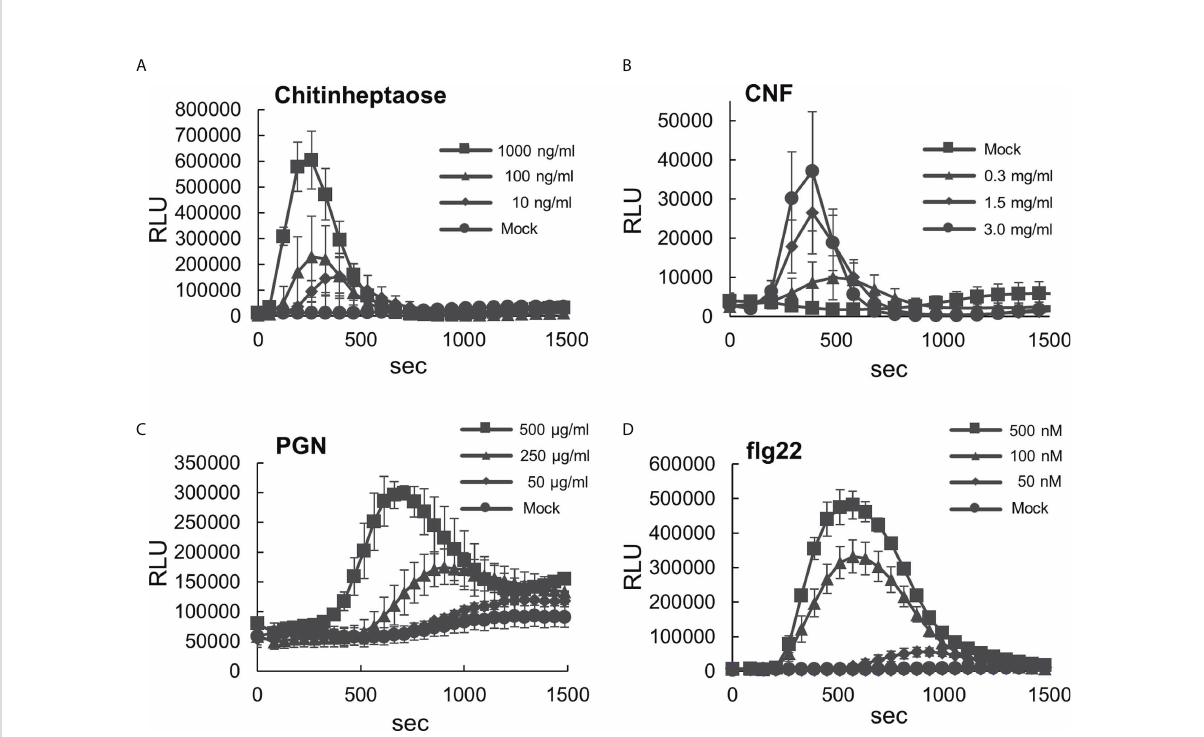
FIGURE 1 Analysis of reactive oxygen species (ROS) production in the leaf disks of Brachypodium distachyon treated with various MAMPs. (A – D) Leaf disks of B distachyon treated with chitinheptaose (A) , fl g22 peptide (B) , peptidoglycan (C) , and chitin nano fi ber (D) . Fluorescence was measured using a microplate reader and expressed as a relative light unit (RLU). Data represent mean ± standard error ( n =